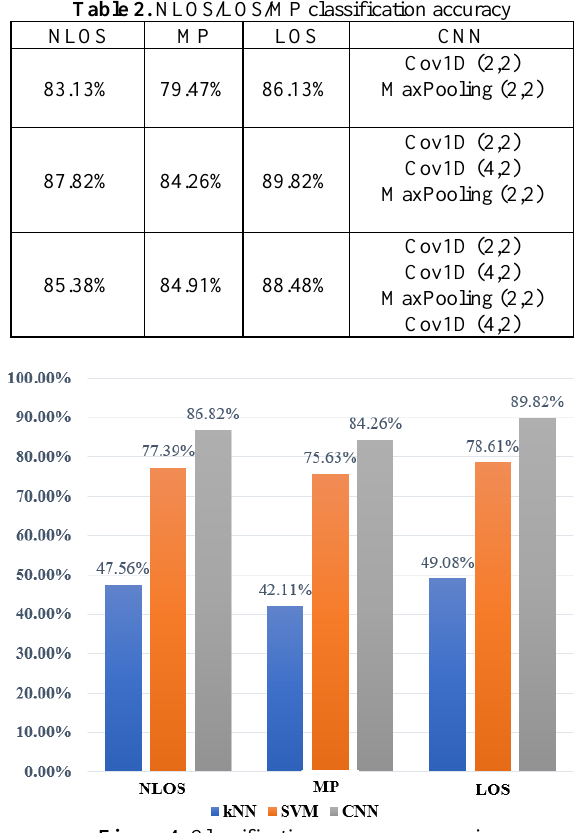
Figure 4. Classification accuracy